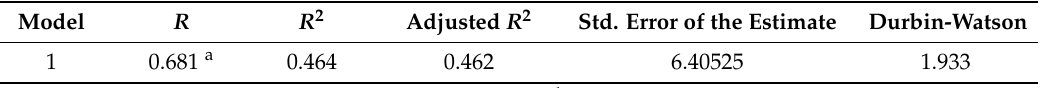
Table 7. Model Summary b